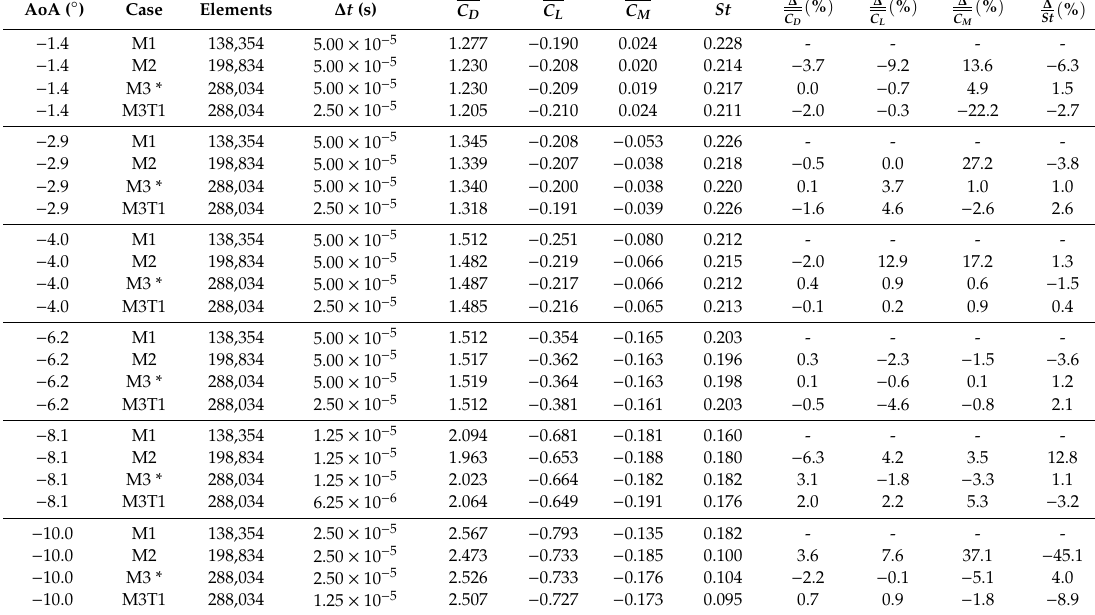
Table 2. Aerodynamic parameters for di ff erent grid and time resolutions for AoA < 0 ◦ .